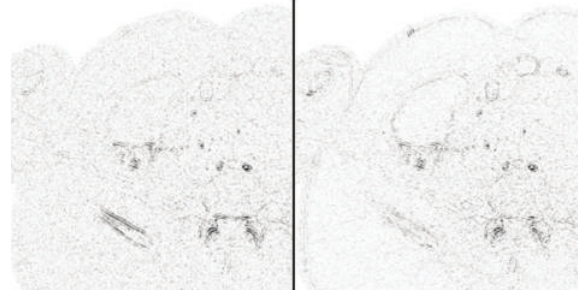
Figure 14: Abdomen reconstruction errors with respect to the reference image (darker shade corresponds to a larger error). Left: PWLS, right: our method (stage II).